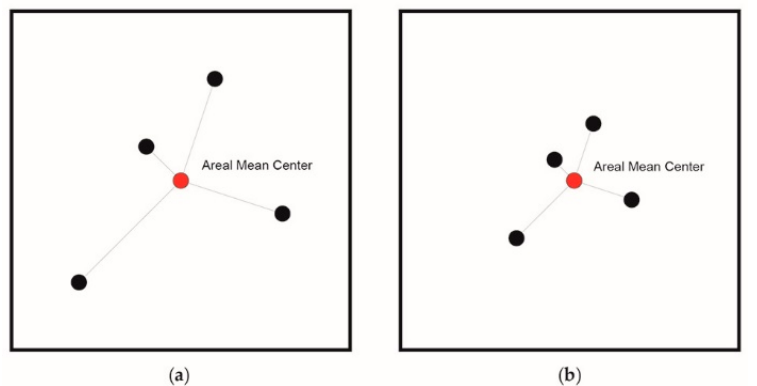
Figure 1. Standard distance vs. density: given that both ( a ) and ( b ) have the same area and number of